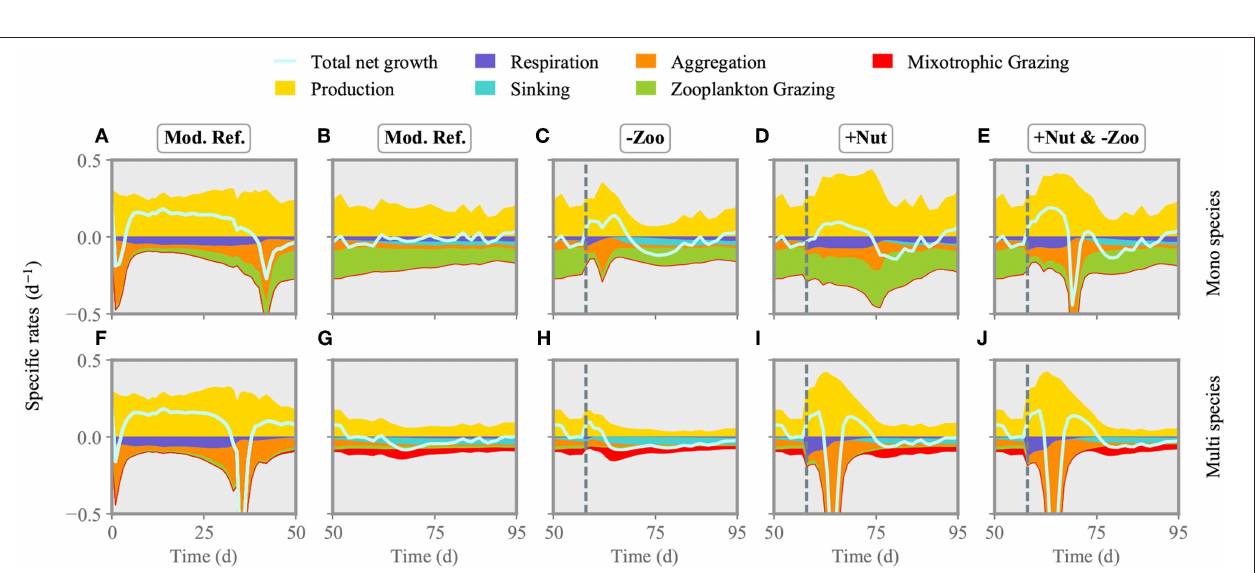
FIGURE 3 | Specific rates and phytoplankton biomass distribution for the reference run under high p CO 2 condition (HpCO 2 ). (A) Total phytoplankton production and loss rates over the time of experiment. (B) Individual phytoplankton biomass distribution. Dashed lines denote different phases of the experiment: initial, first and second spring bloom, and post-bloom. The size range corresponds to 0.6–500 µ m ESD.